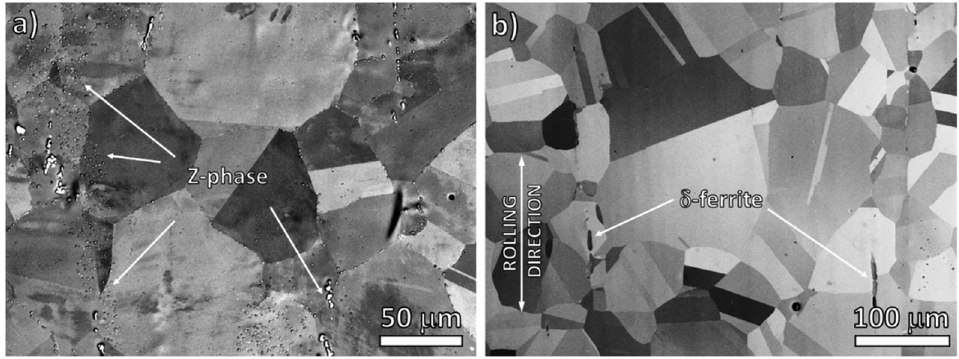
Table 2. The chemical composition of 304L in wt.% provided by producer.